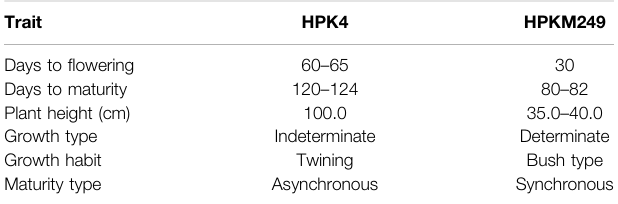
TABLE 1 | Variations in parents for different